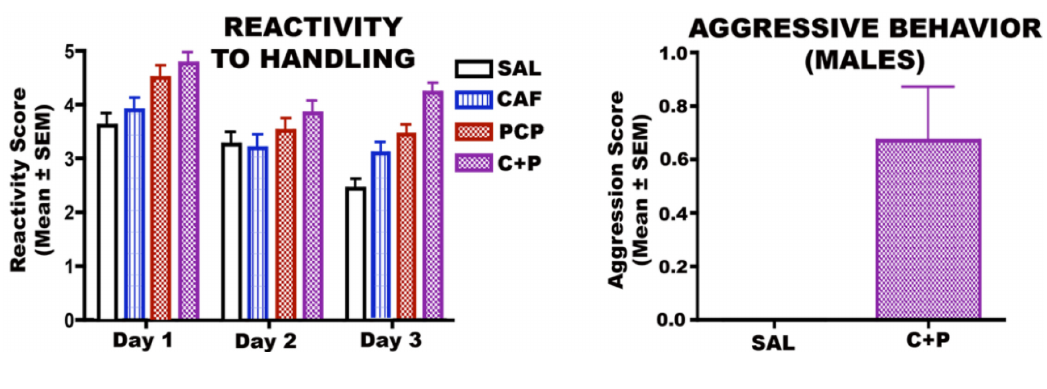
Figure 10. Reactivity to Handling and Male